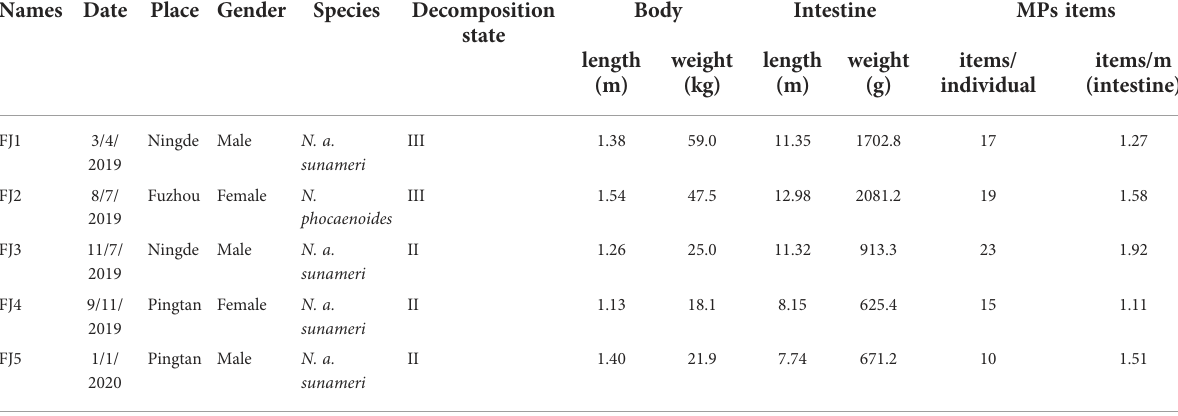
TABLE 1 Basic information of the stranded fi nless porpoises. Names Date Place